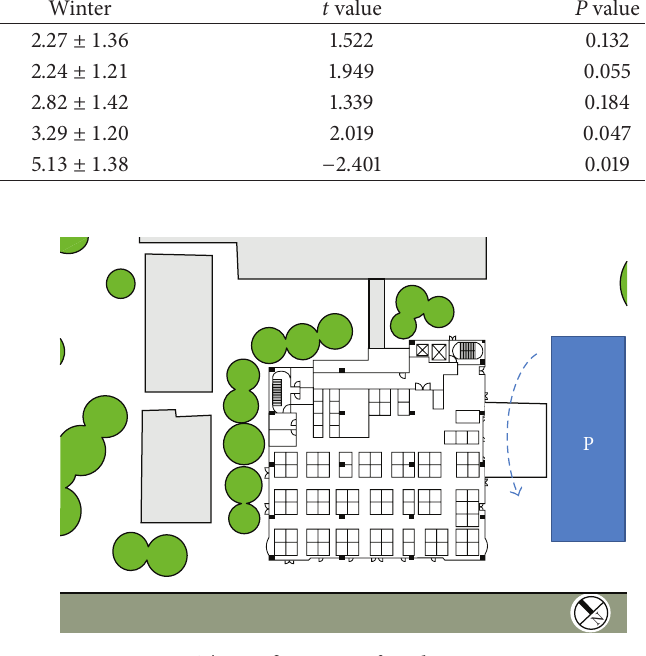
Figure 6: The configuration of outdoor